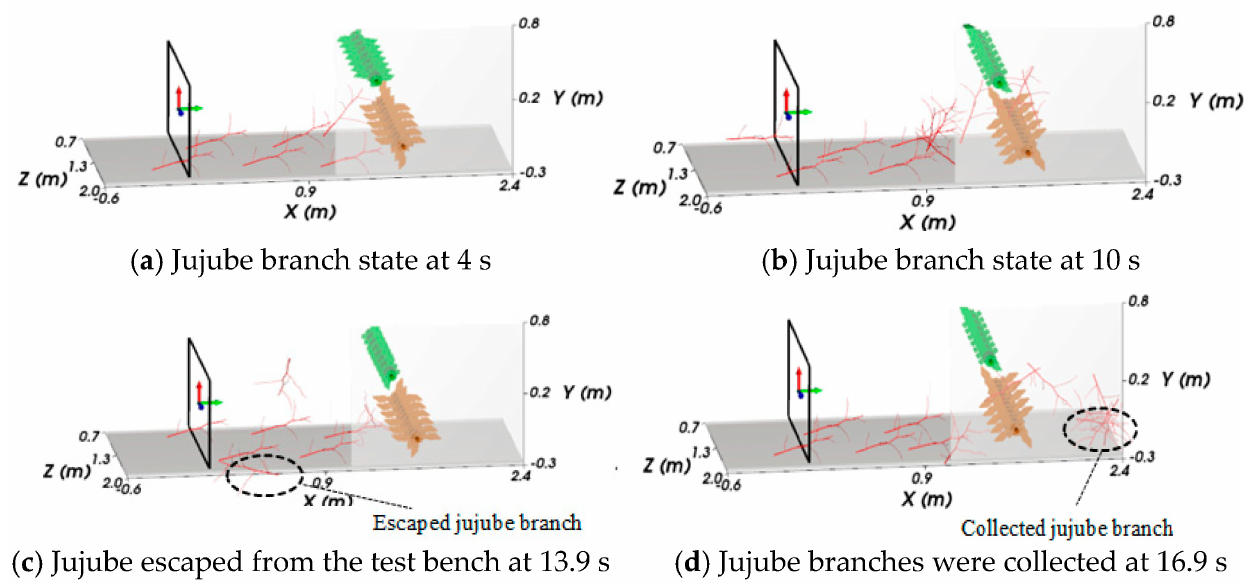
Figure 4. Dynamic picking process of jujube